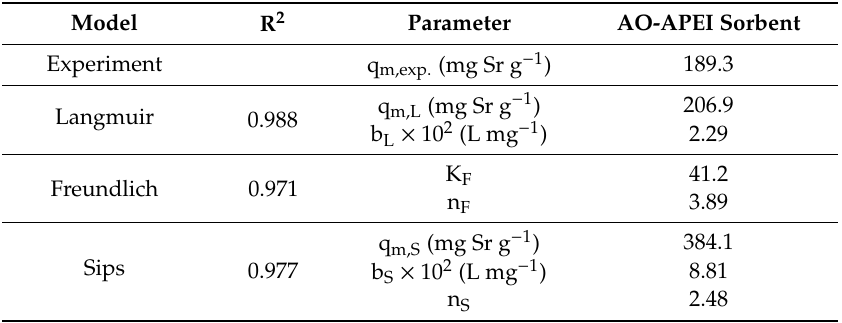
Table 2. Sorption isotherms for Sr(II) binding onto AO-APEI. The parameters of the models.